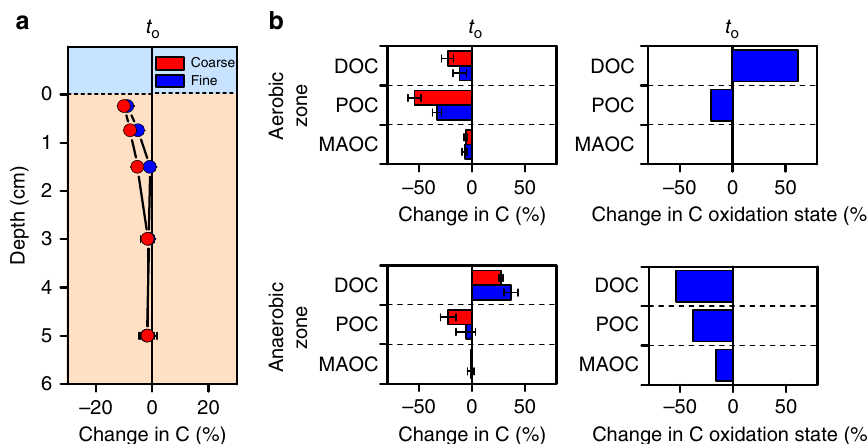
Fig. 4 The effect of particle size-induced variations in the extent of anaerobic microsites on the microbial oxidation of different carbon pools. a Changes in total carbon across the diffusion-limited domain within the reactor. b Changes in dissolved, particulate, or mineral-associated organic carbon pools in the aerobic and anaerobic zone. Dissolved (DOC), particulate (POC), and mineral-associated organic carbon (MAOC) are listed in order of decreasing bioavailability. c Changes in carbon oxidation state in reactor experiments. The changes in oxidation state are calculated as the ratio of the absorbance of carboxyl (288.35 eV) to that of aromatic C (285.05 eV) in spectra obtained by near-edge X-ray absorption fi ne structure (NEXAFS) spectroscopy. Changes in carbon pools and oxidation state are shown relative to a time-zero control ( t 0 ). Particle size variations to manipulate the extent of anaerobic microsites are shown in red (coarse = 150 – 250 µ m) and blue (25 – 45 µ m). Error bars denote the standard error of the mean calculated from four